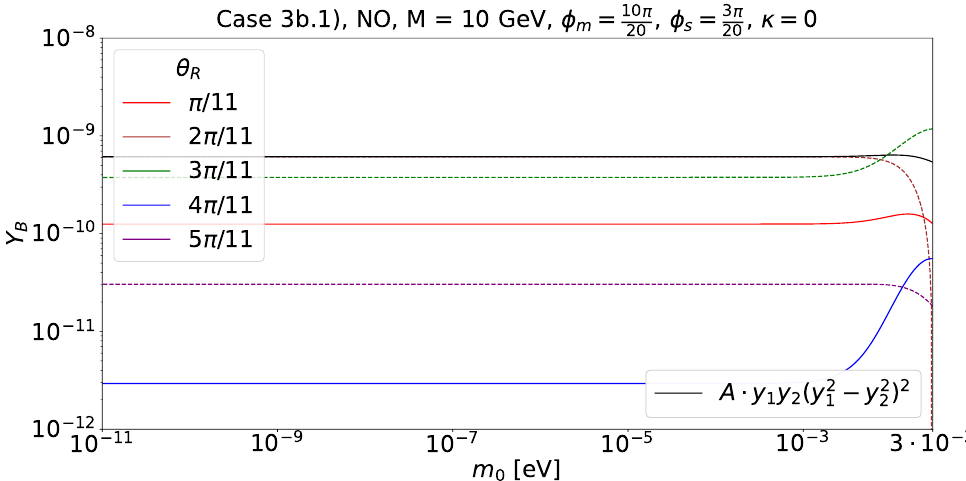
Figure 39 . Case 3 b.1) Y B as function of the lightest neutrino mass m 0 for a Majorana mass M = 10 GeV and for different values of θ R in absence of the splitting κ (and λ ). Light neutrino masses have NO. The group theory parameters are fixed to n = 20 , m = 10 and s = 3 . For θ compare the numerical results (brown dashed curve) with the analytical expression A · y (continuous black line) with A ≈ − 8 . 16 · 10 31 . This expression reflects the dependence of the BAU, due to the CP-violating combination C (dashed lines) as well as positive (continuous lines) values of the BAU are